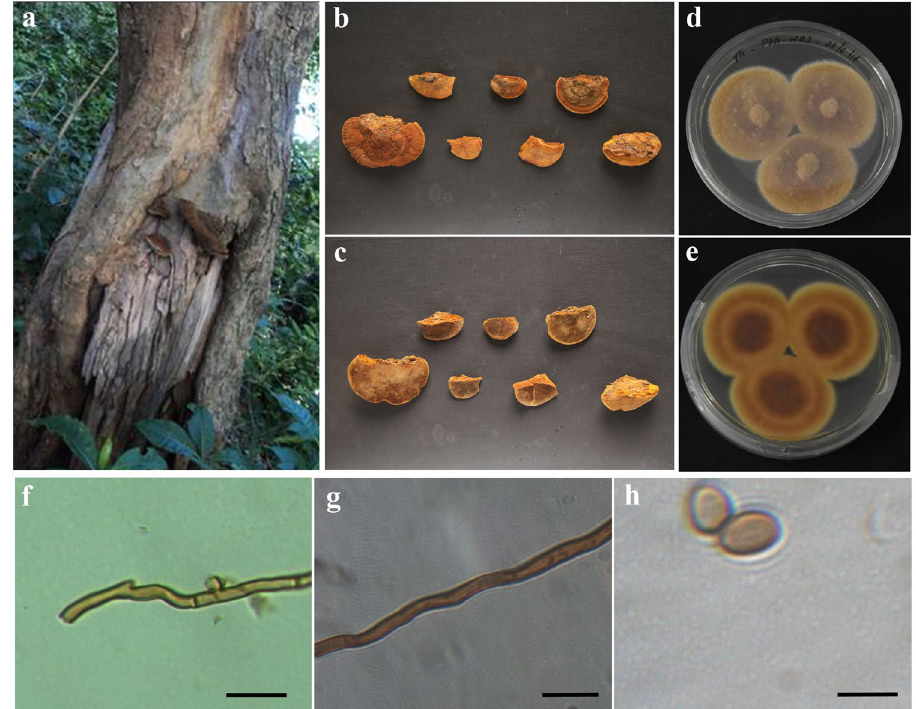
Figure 10. Morphology of Phellinus badius . ( a ) Basidiomata attached to the host; ( b ) Pileal surface; ( c ) Hymenial surface; ( d , e ) Pure culture; ( f ) Skeletal Hyphae; ( g ) Generative hyphae; ( h ) Basidiospores. (Scale: 40X– f & g; 100X–